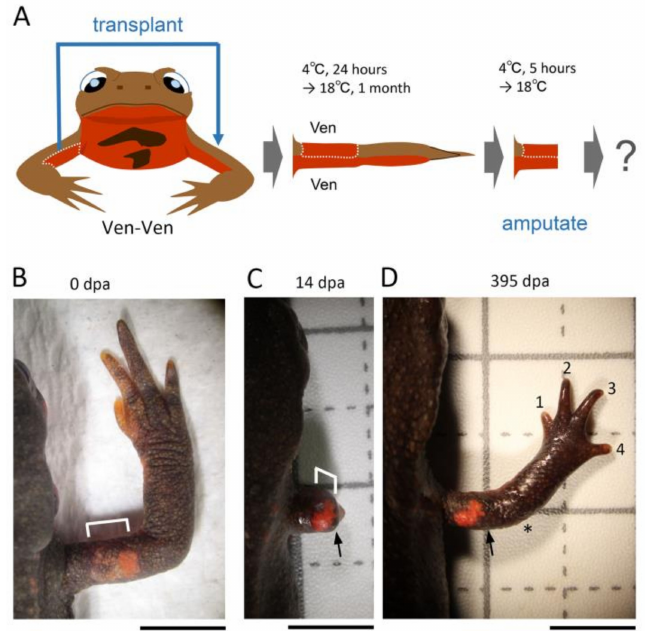
Figure 5. Effects of Ventral-Ventral (Ven-Ven) skin grafting on limb regeneration. ( A ) Schematic showing the surgical process. ( B ) A limb immediately before amputation. ( C , D ) Representative image showing normal regeneration (n = 31). The bracket indicates the grafted skin. The number near the digit indicates digit number. The asterisk indicates the elbow. The arrow indicates the amputation position. dpa: day post amputation. Scale bars: 5